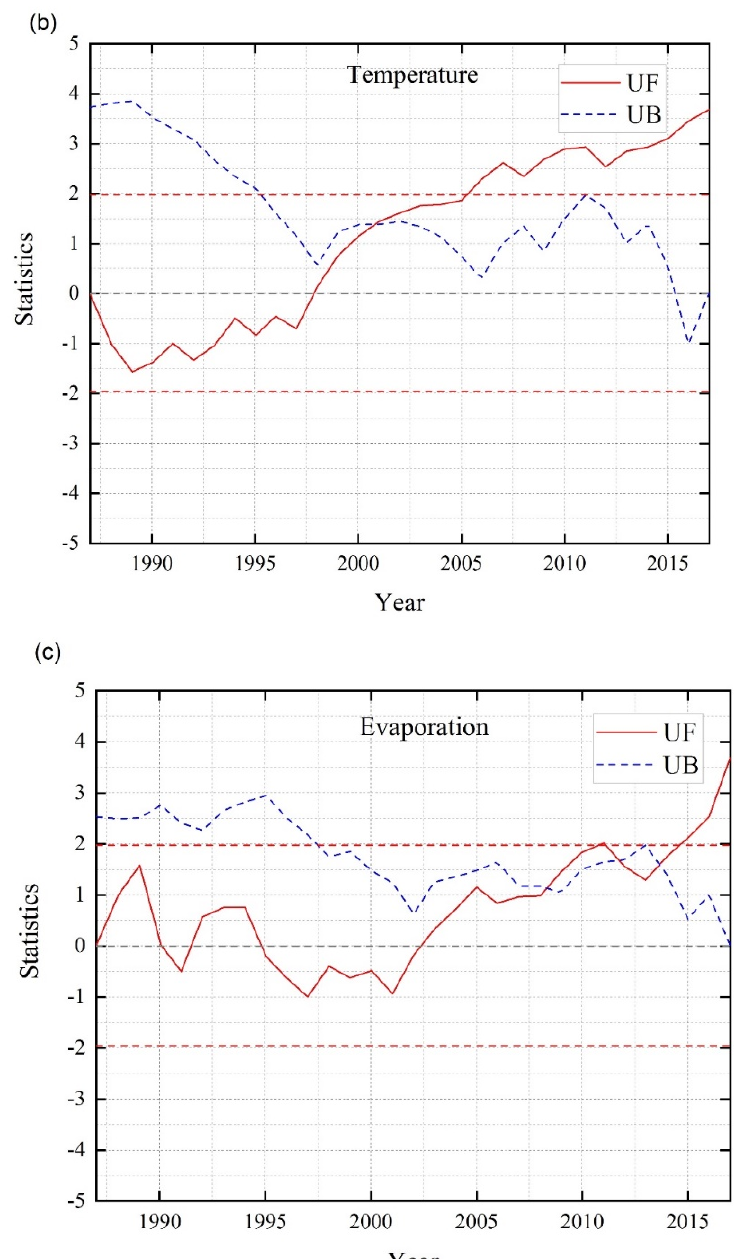
Figure 8. Trend test and abrupt change point detection of temperature, precipitation and evaporation in the Hala Lake watershed; the red dotted lines are the thresholds at a significant level of 95%; statistics are the values of UF and UB.